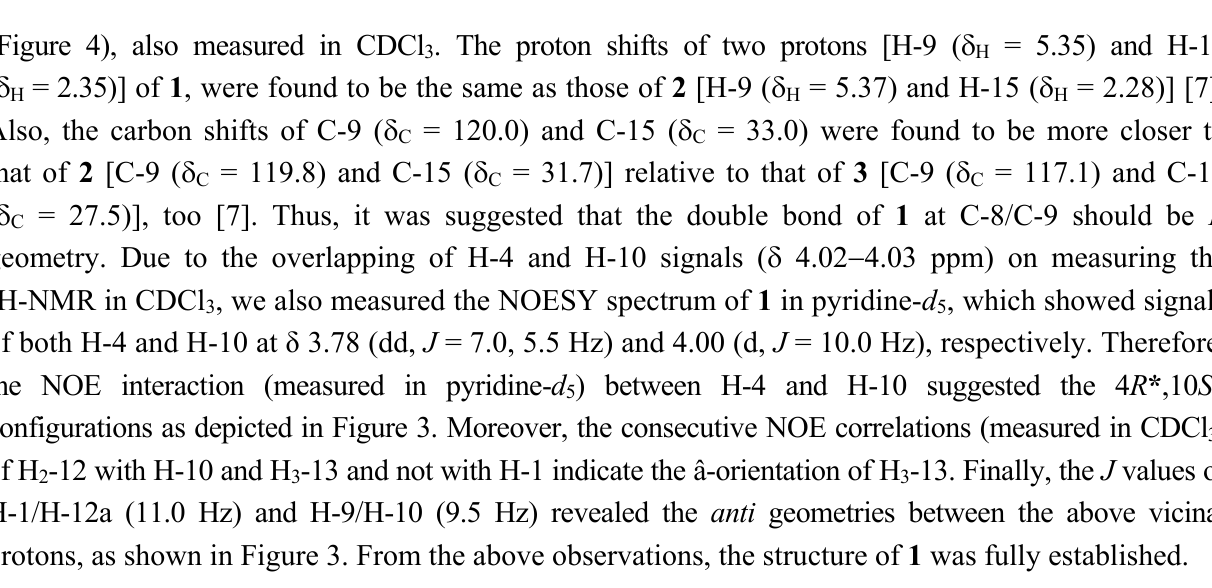
Figure 3. Selective NOESY correlations and coupling constants ( J ) of 1 .